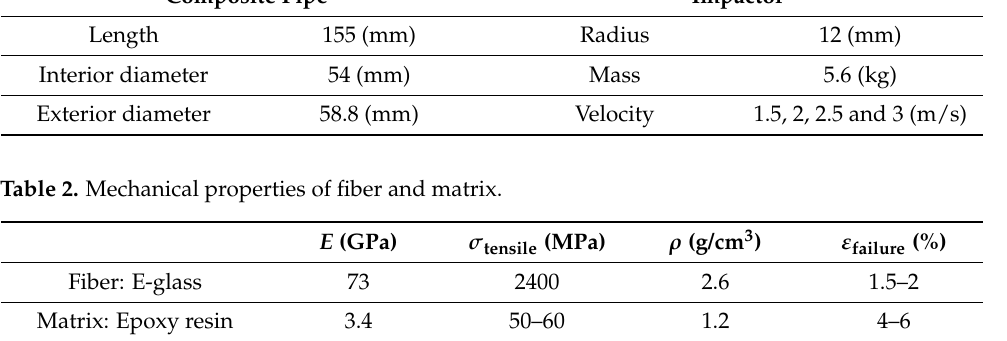
Table 2. Mechanical properties of fiber and matrix.